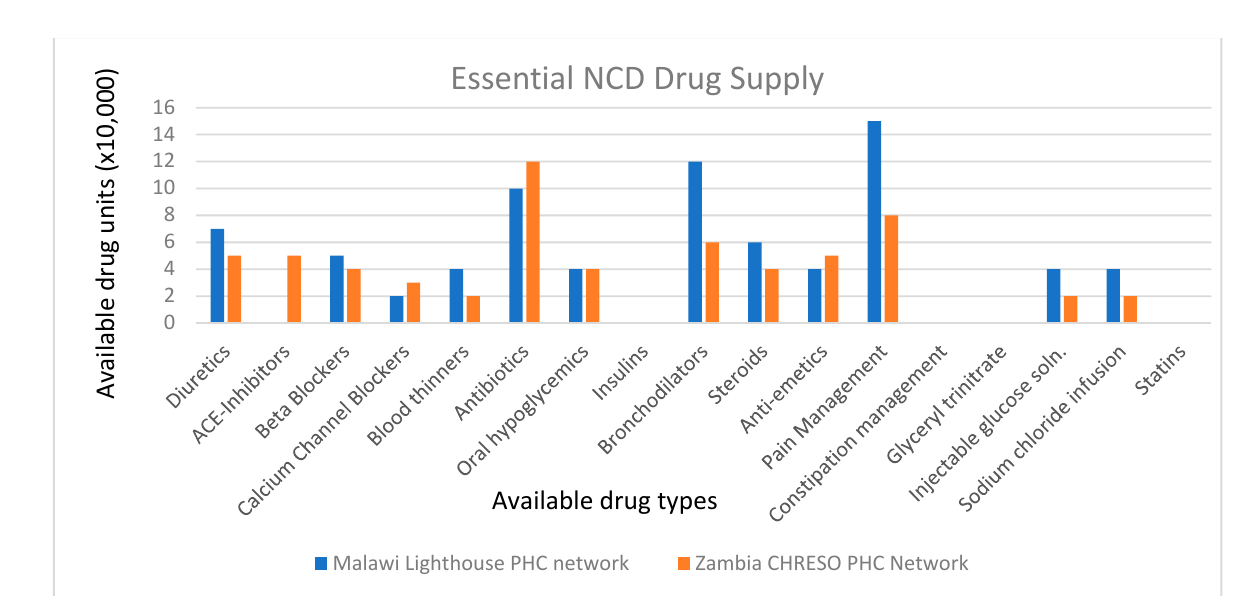
Figure A1. Availability of essential NCD medicines (by 18 drug types) in the assessed PHC sites.